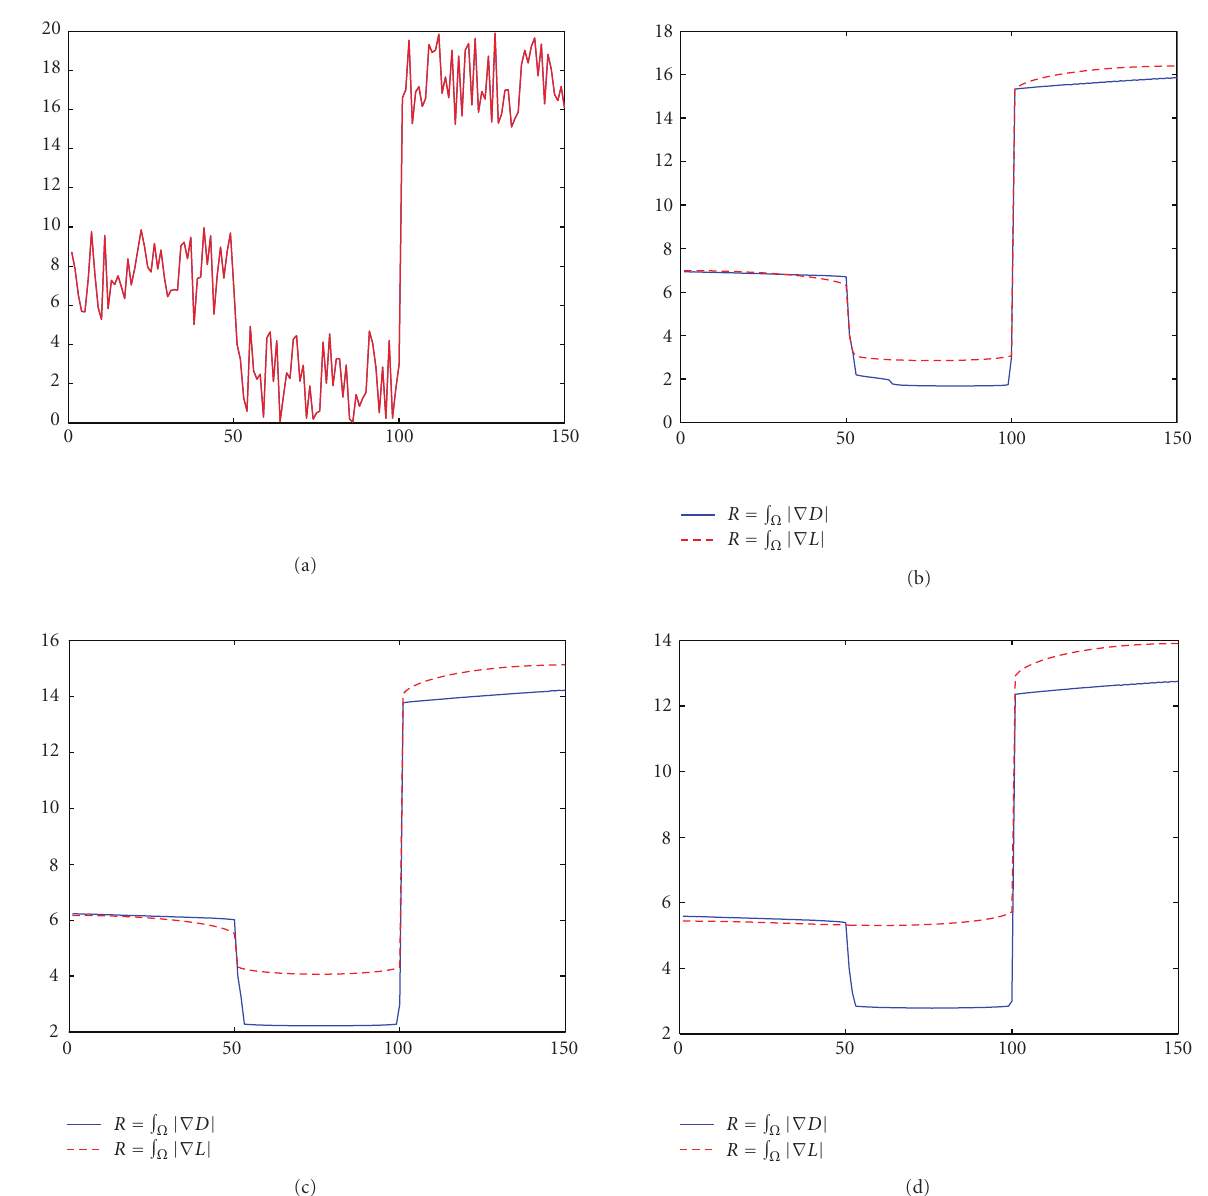
(cid:30) (cid:30) |∇ L | and |∇ D | . The noisy signal in (a) Ω Ω